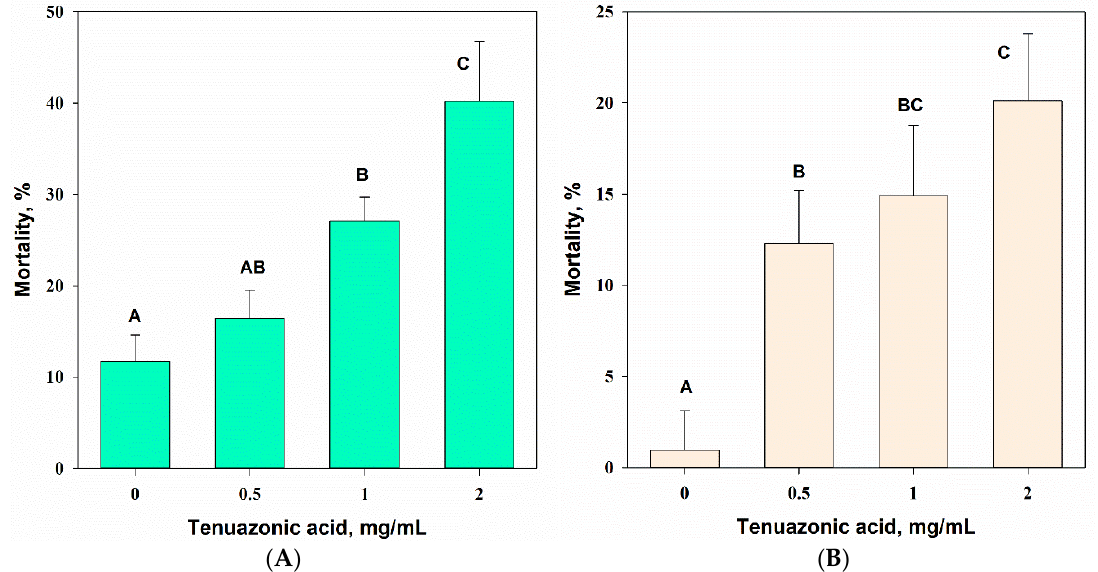
Figure 11. Toxicity of various concentrations of tenuazonic acid against Schizaphis graminum ( A ) and Tetranichus urticae ( B ) 24 h post treatment. Means ± std. deviation marked with the same letter did not differ significantly at the level of p = 0.05 according to Tukey’s HSD test.